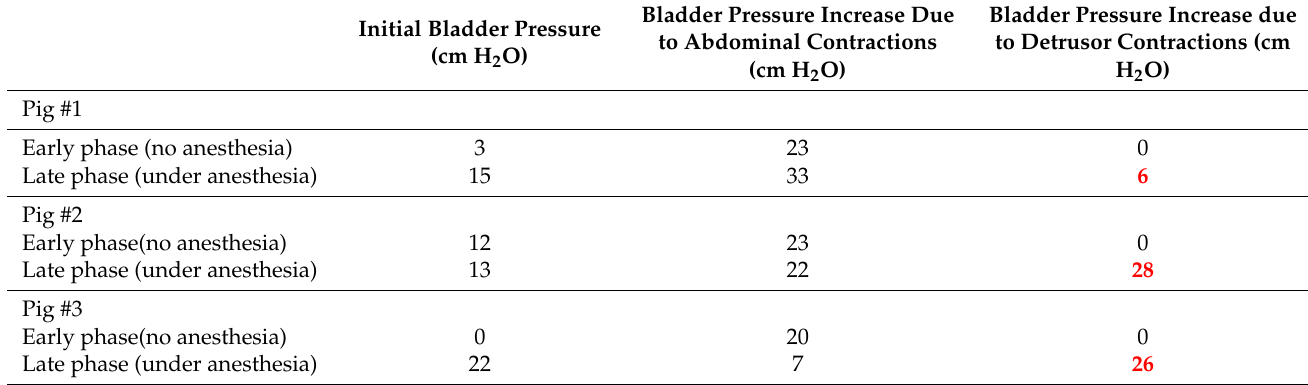
Table 1. Responses to 40 Hz four electrode stimulation at 10 mA in the conscious animal during early testing days (average values from postoperative days 4 and 7) and at 60 mA under anesthesia during the late testing days (average values from postoperative days 9 and 28) from the three minipigs. The important vesical wall contraction increases in pressure are highlighted in